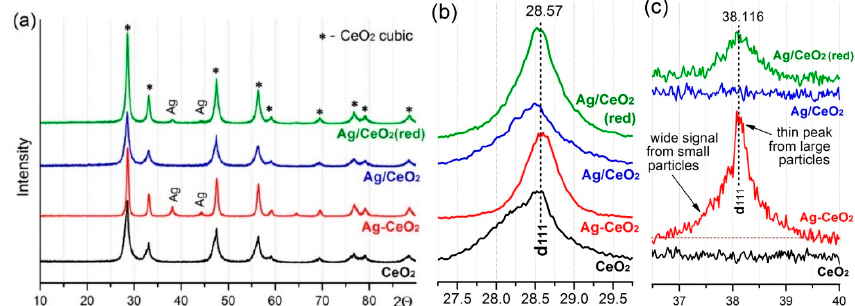
Figure 2. The powder XRD patterns for catalysts: panoramic spectrum ( a ), the detailed peaks of CeO 2 (111) ( b ) and Ag (111) ( c ). Table 2. Structural parameters of the Ag catalysts and CeO 2 support.